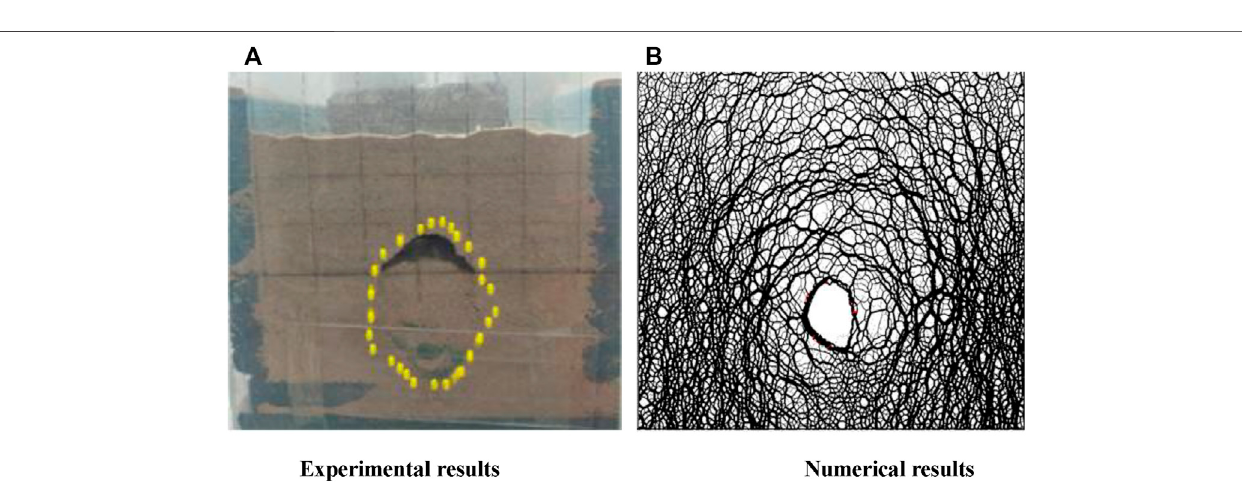
FIGURE 13 | Experimental and numerical results of 20 m deep tunnel after earthquake. (A) Experimental results. (B) Numerical results.